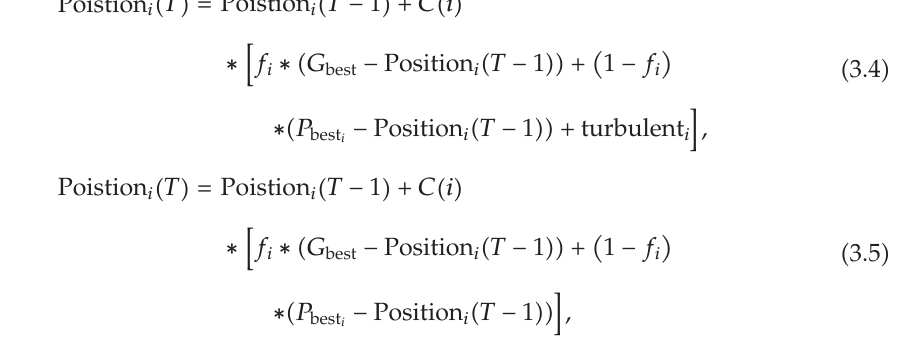
Figure 2 (cid:3) a (cid:4)(cid:4) and random oriented (cid:3) Figure 2 (cid:3) b (cid:4)(cid:4) . Group exchange means group oriented (cid:3) Figure 2 (cid:3) c (cid:4)(cid:4) . But in each generation, every bacterium has only one type of the